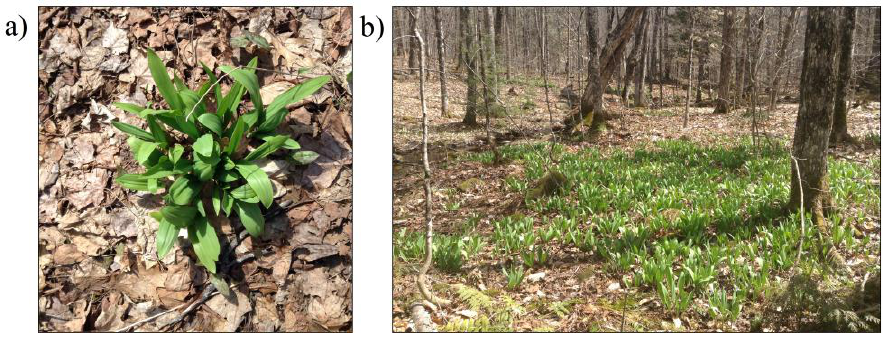
Figure 1. ( a ) Small and ( b ) bigger patch of wild leek in Gatineau Park, Quebec. Photos taken on 12 May 2016. Wild leek form dense patches that can cover large areas, unlike other spring ephemerals that tend to grow more sporadically.